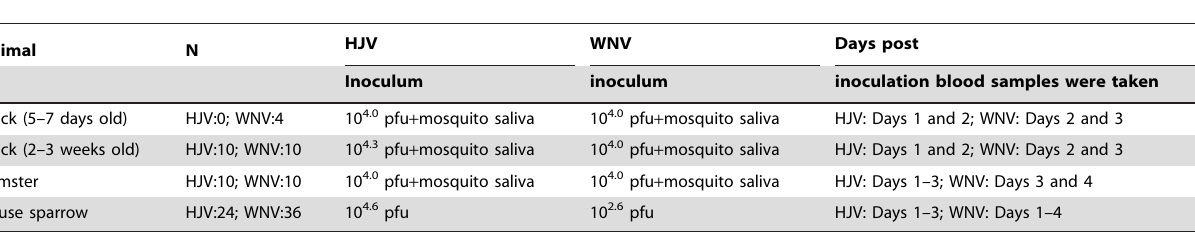
Table 1. Animals, viruses, and days post inoculation each animal was sampled by syringe and mosquito.